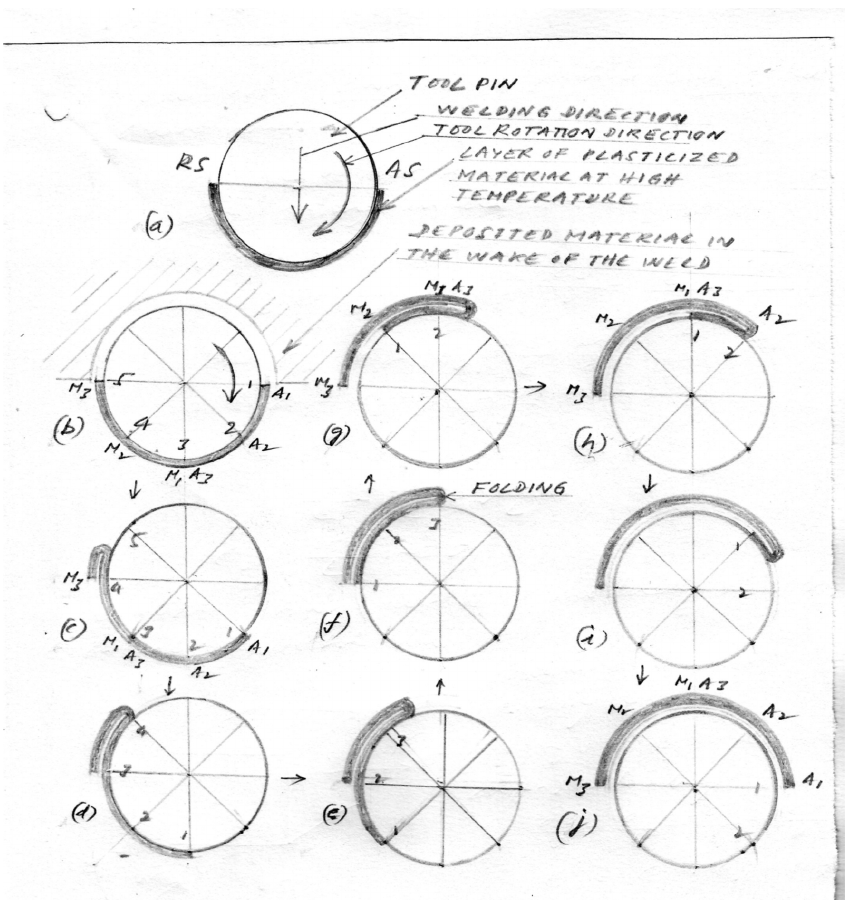
Figure 12: 1, 2, 3, 4, 5 are the points on the periphery of the tool pin. A1, A2, A3 are the Al material regions on the Al side (AS). M1, M2, M3 are the Mg material regions on the Mg side (RS). A1, A2, A3, M1, M2, M3 is the layer of material (A and B), which is transferred and deposited as A1, … M3 (J) to backside of the tool pin. This process repeats (B – J) itself for revolutions after